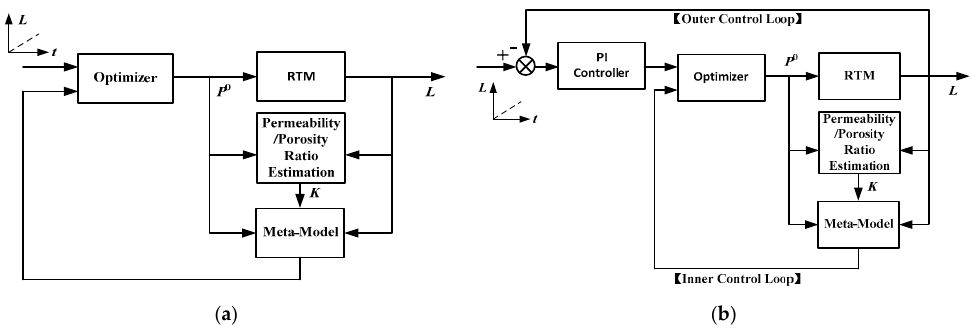
Figure 4. Diagrams of ( a ) the model predictive control system; ( b ) the cascade control system.